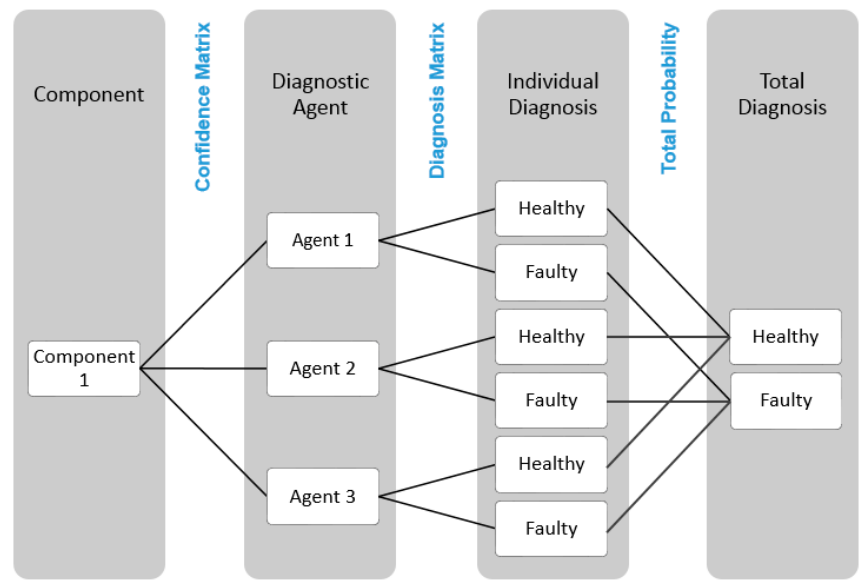
Figure 3. Framework of a multi-agent diagnostic model for one wind farm component.